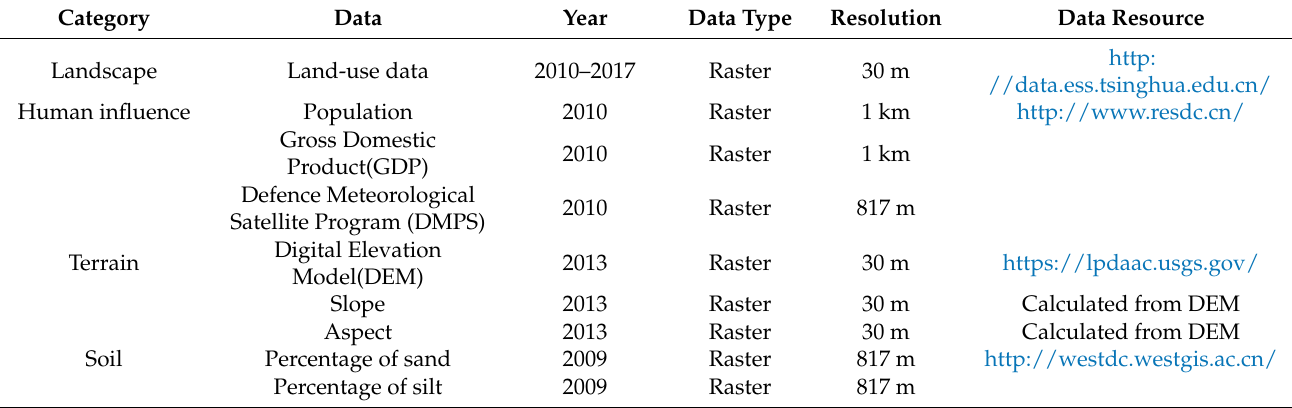
Table A1. Details of data used in this